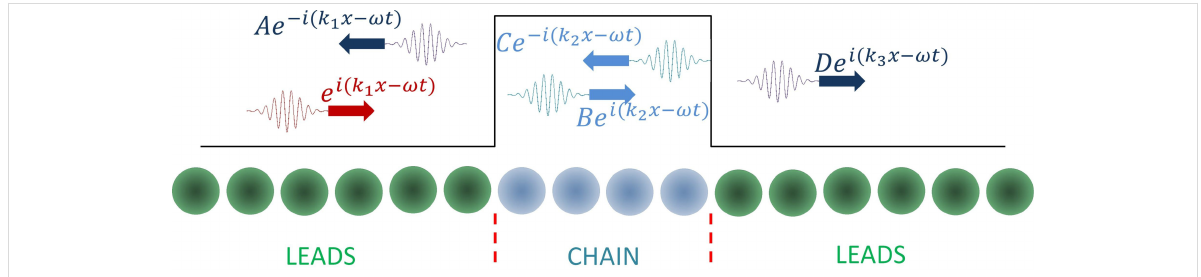
Figure 7: A one-dimensional model of electronic transport through a monoatomic chain [50]. To differentiate between the atomic chain and the leads, a different wave vector k 2 is assigned to the chain as compared to k 1 and k 3 for the leads. This difference in wave vector can be manifested as a potential barrier and the electrons form standing waves inside the barrier. Depending on the length of the barrier one can have different interference patterns of these standing waves giving oscillations in the conductance. This is similar to a Fabry–Pérot interferometer. The different colours of atoms here do not imply different types of atoms but are used only to differentiate between the leads and the atomic